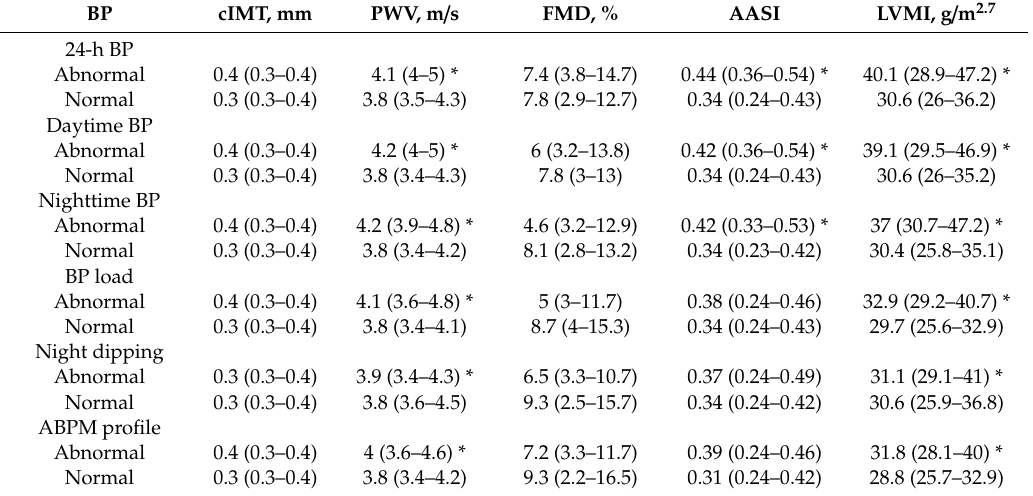
Table 4. Cardiovascular parameters vs. ABPM profile in children and adolescents with CKD.